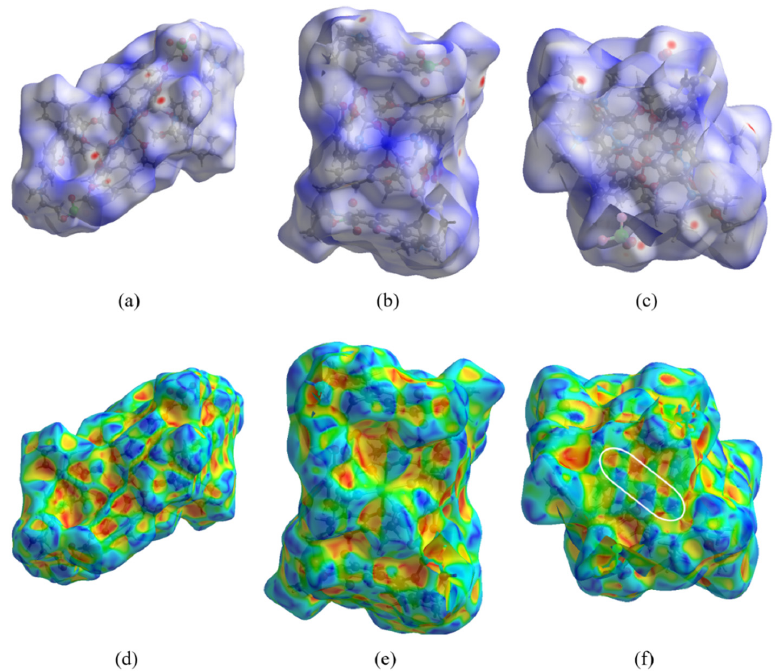
Figure 5. ( a – c ) d norm mapped on the Hirshfeld surface seen along the three axes a , b , c (d norm from − 0.1592 to 2.2565). ( d – f ) Shape index mapped on the Hirshfeld surface seen along the three axes a , b , c (shape index from − 1.0 to 1.0).